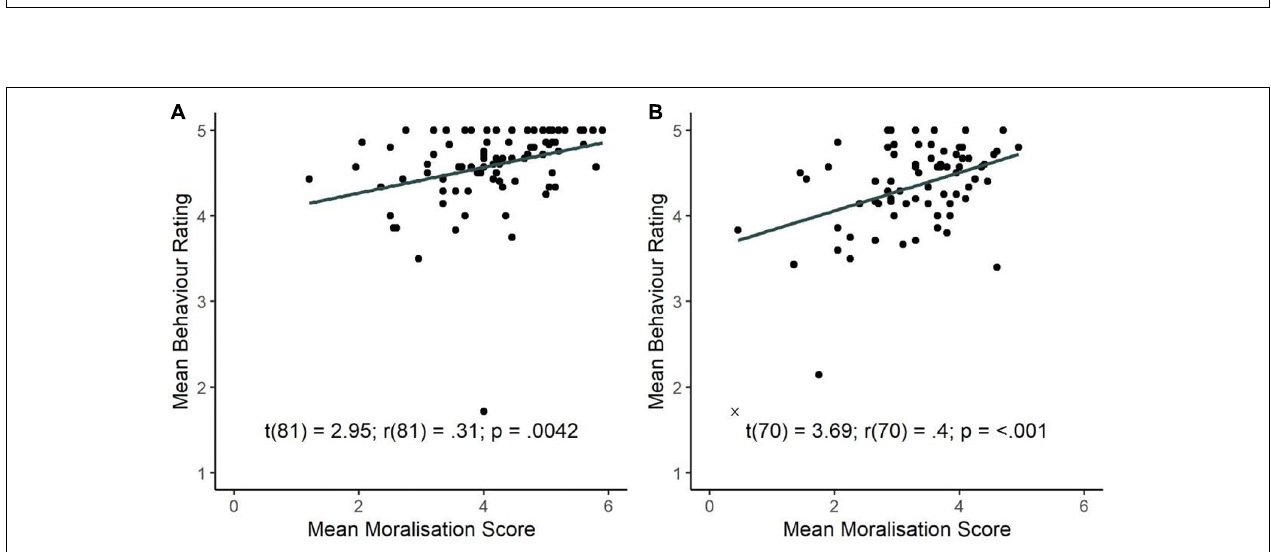
FIGURE 5 | Relationship between moralisation of government-recommendations (mean MB-CV19 score) and engagement in government-recommended behaviours during COVID-19 pandemic at (A) timepoint 2 (April 2020) and (B) timepoint 3 (September 2020). Excluded participant is denoted by “x” and was not included in the